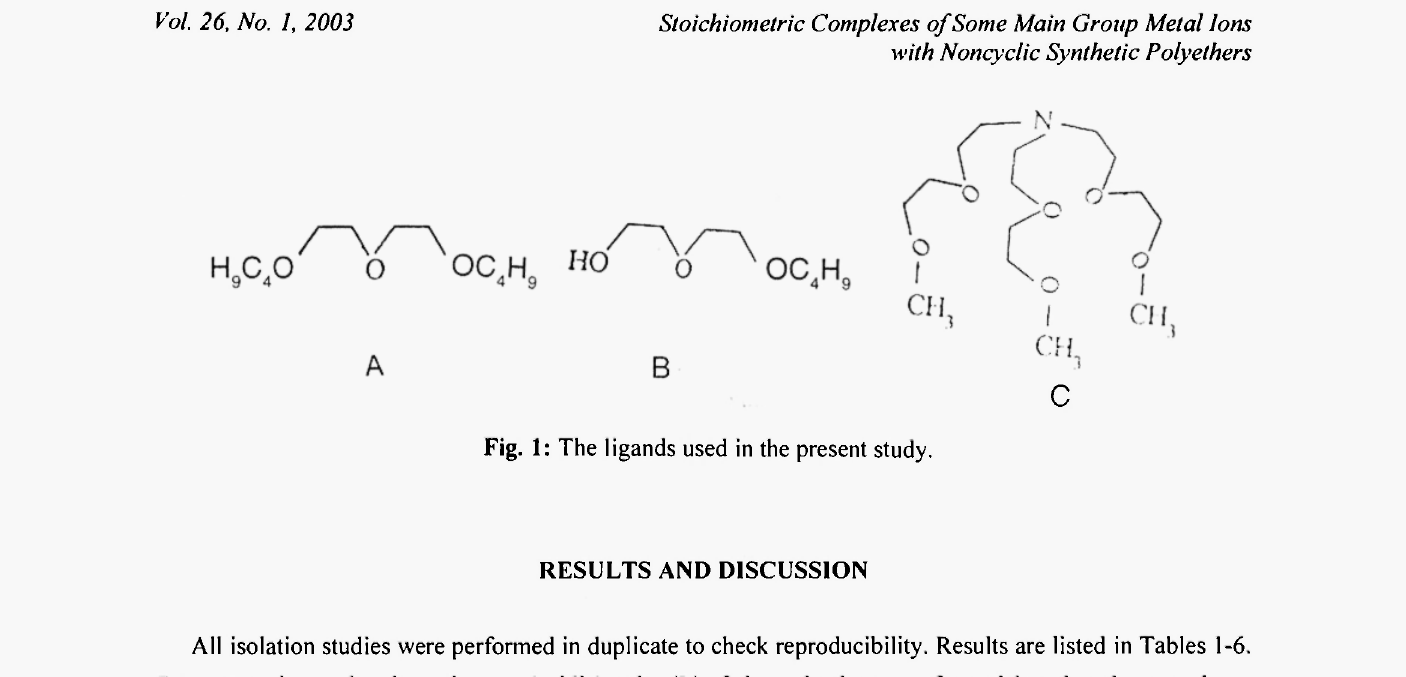
Fig. 1: The ligands used in the present